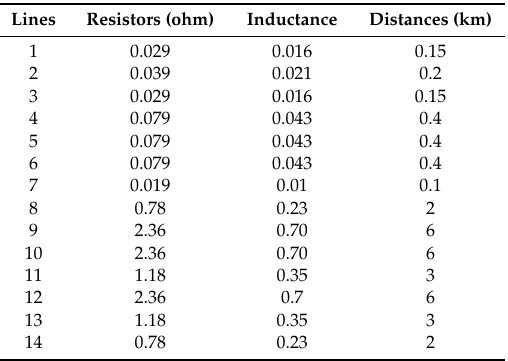
Table 3. Microgrid line